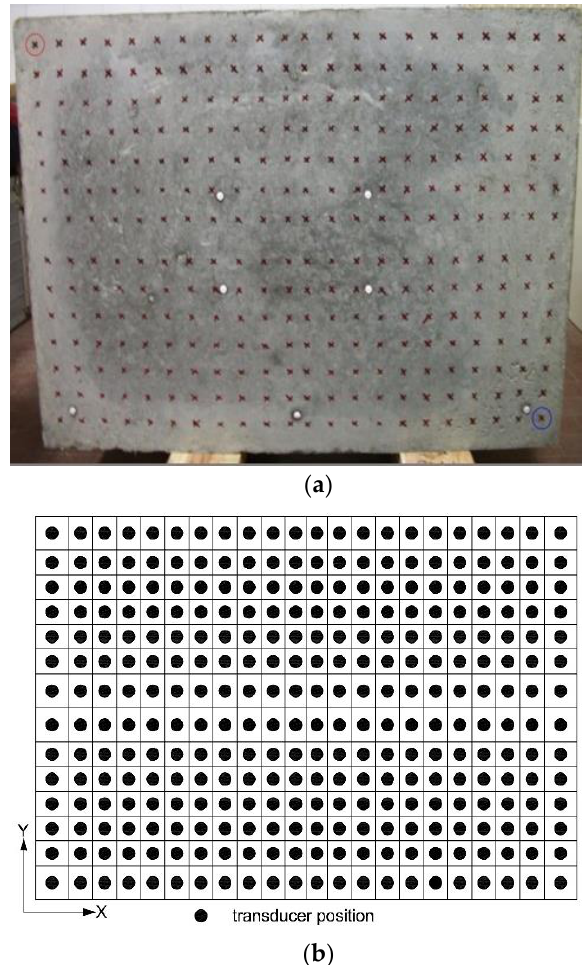
Figure 2. Transducer position in grid A ( a ) and scheme of transducers position in grid C ( b ).